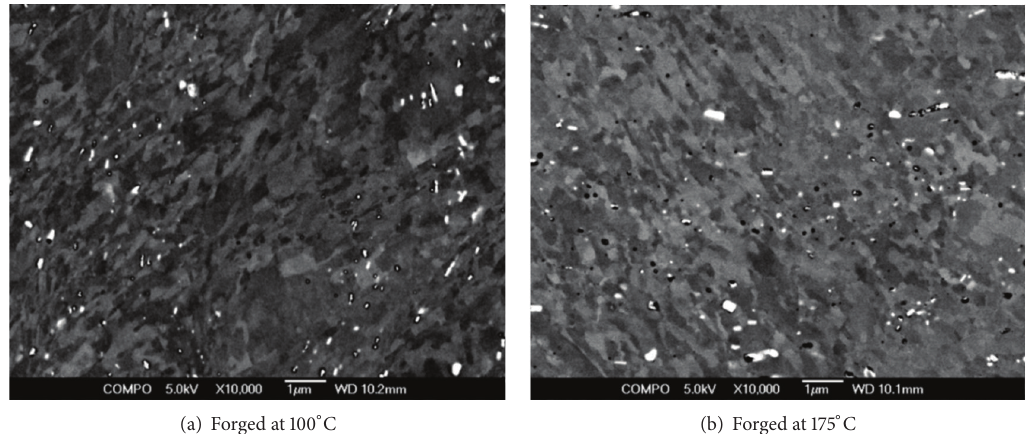
Figure 9: SEM micrographs at 10000x of zone 2 of the blades with N2 as starting